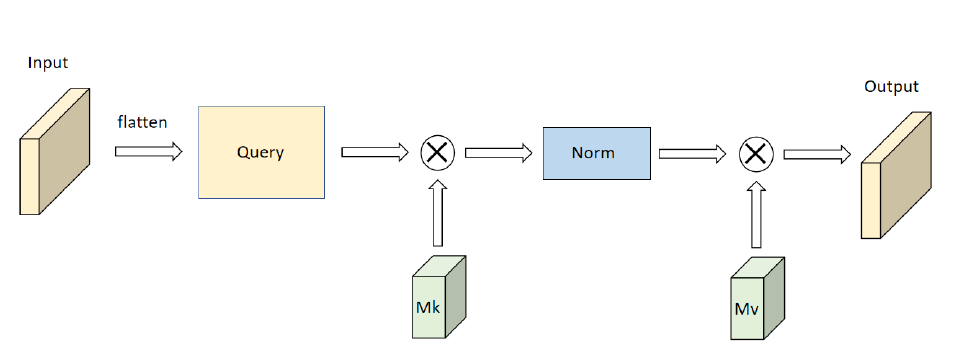
Figure 4. External attention. F represents the feature map flattened by the input, and A represents the attention feature map obtained from prior knowledge.